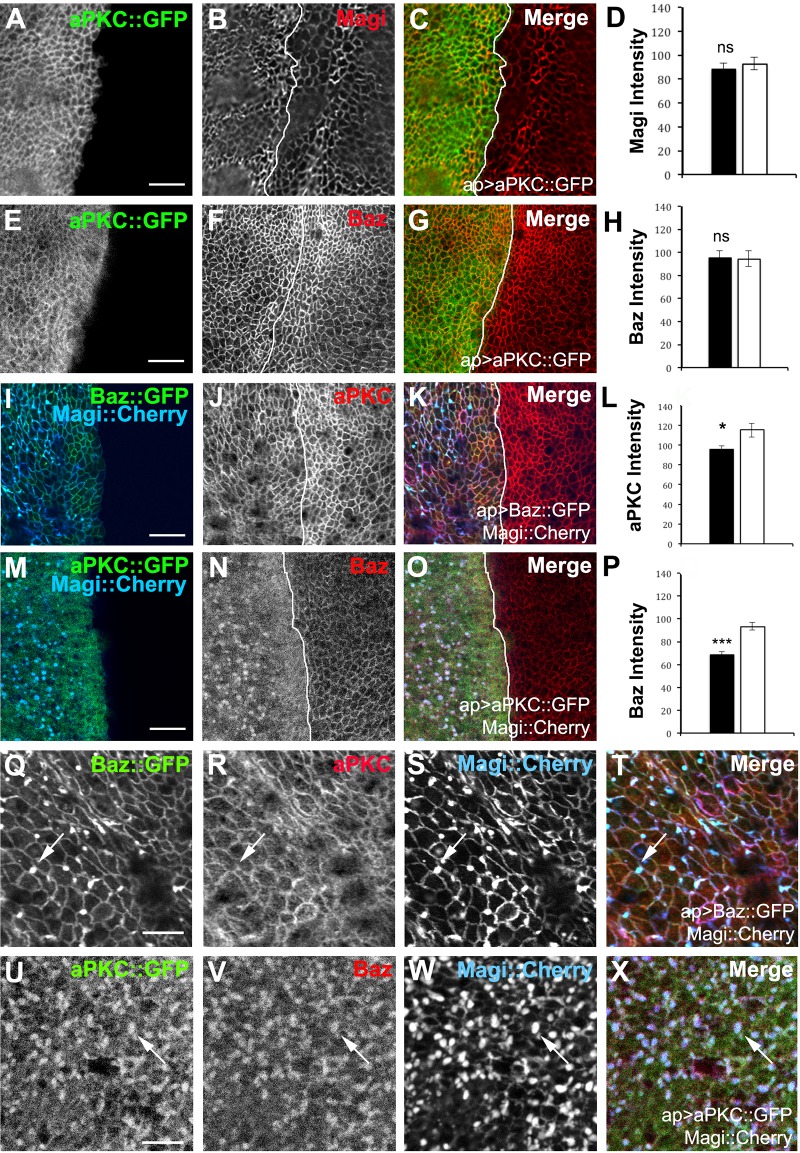
A balance between the levels of Magi and Baz regulates aPKC membrane levels.apterous-GAL4 was used to overexpress different combinations of tagged proteins in the wing imaginal disc. The average membrane intensity of each protein was measured and compared between the apterous (black bars) and non-apterous (white bars) side of the wing imaginal disc. The white lines mark the apterous dorsal/ventral boundary. (A-H) Overexpression of aPKC::GFP (green) had no effect on the membrane localization or levels of Magi (red) (A-D) or Baz (red) (E-H). (I-L) Co-expression of Magi::Cherry (blue) and Baz::GFP (green) attenuated the changes in aPKC (red) caused by high levels of Baz or Magi alone. aPKC levels were not increased by overexpression of Baz::GFP when Magi::Cherry was co-expressed. (M-P) Coexpression of Magi::Cherry (blue) and aPKC::GFP (green) lead to a reduction in the Baz membrane levels (red) and increased accumulation in the Magi vesicles. Overexpression of wildtype aPKC did not block the Magi induced reduction in Baz. (Q-X) Higher resolution image of the large accumulations seen with Magi::Cherry expression at the basolateral region of the epithelial cells. Each panel was digitally magnified 200%. (Q-T) Co-expression of Magi::Cherry (blue) and Baz::GFP (green) lead to the accumulation of Baz and Magi within the large internal accumulations. aPKC (red) was only weakly recruited (arrows). (U-X) Co-expression of Magi::Cherry (blue) and aPKC::GFP (green) lead to an increased accumulation of Magi vesicles that were also positive for Baz (red) (arrows). *** p<0.001; * p<0.05; ns not significant. Error bars indicate SEM. n = 5 discs for each experiment. Scale bars indicate 5μm for A-O and 2μm for Q-X.